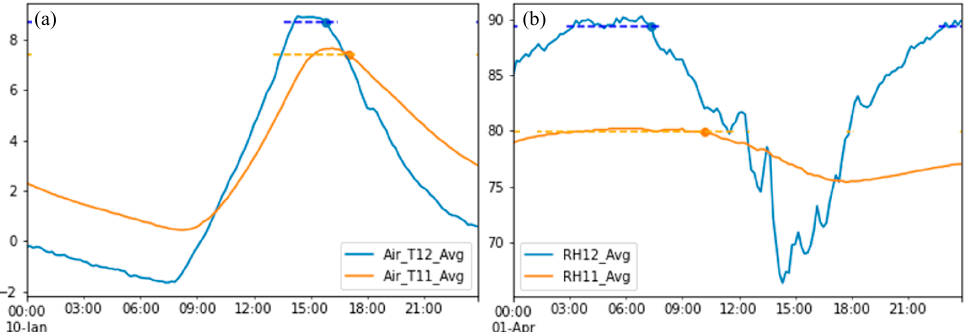
Figure 5. Peak selection of ( a ) temperature; ( b ) relative humidity.